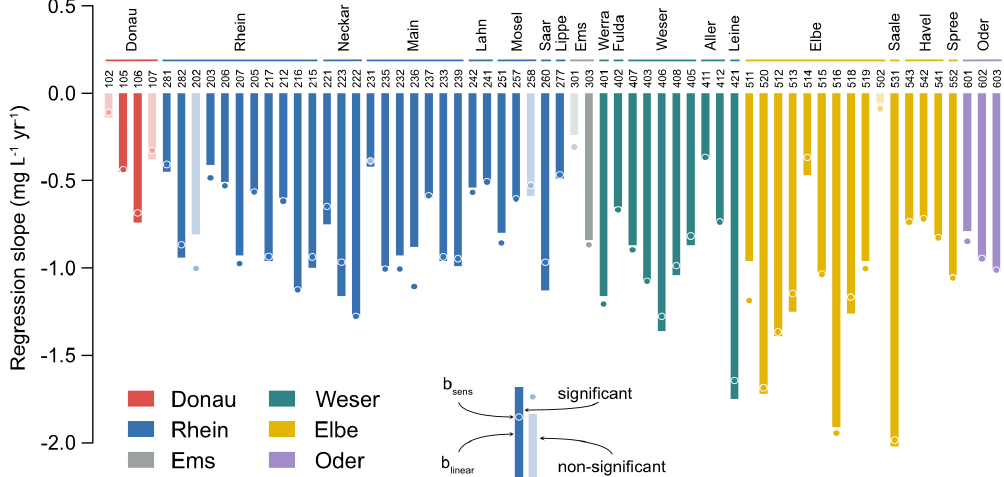
Figure 2. Overview of SSC trends for all 62 stations ordered according to the river systems and flow path from upstream (left) to downstream (right) showing the trends from least-square linear regression and Sen’s